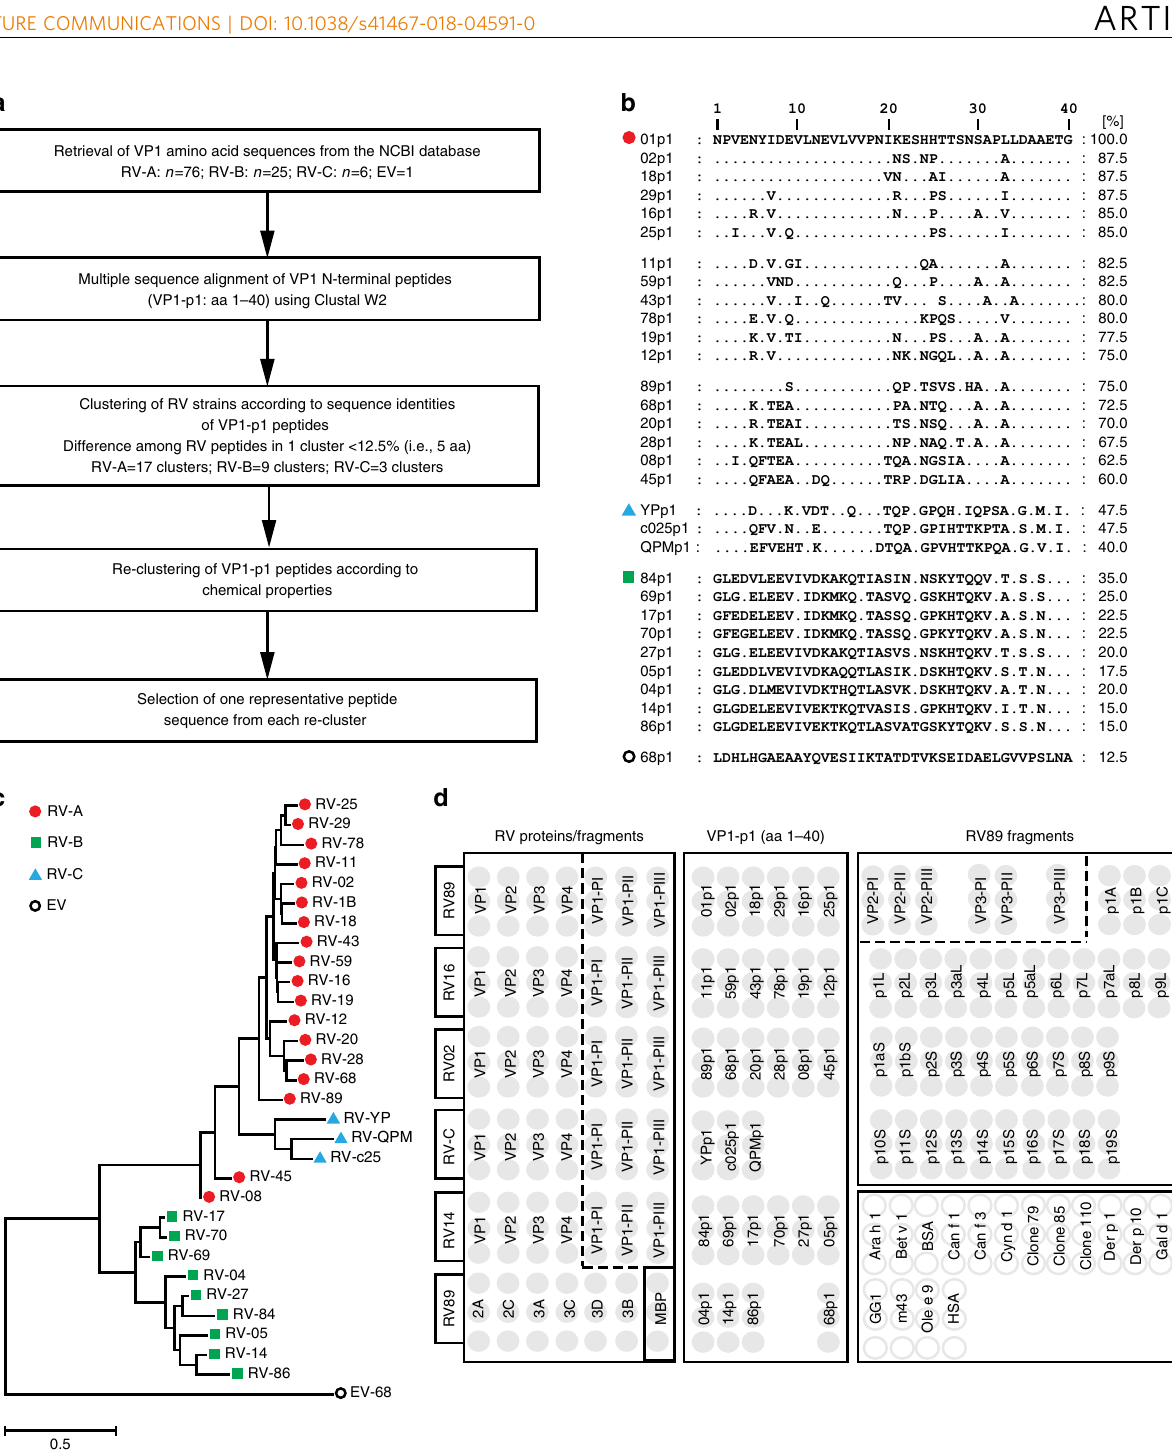
Fig. 1 Composition of the PreDicta chip. a Selection process of VP1 peptides representing different RV strains as summarized in Supplementary Table 2. b Multiple sequence alignment of selected VP1 peptides. Left margin: Strain numbers (red circle: RV-A; blue triangle: RV-C, green square: RV-B, black circle: Enterovirus 68). Dots in the alignment represent identical amino acids. Sequence identities (%) with peptide 1 from RV 1 (01p1; top line) are shown for each peptide on the right margin. c Phylogenetic tree of the VP1 peptide sequences in b . d RV microarray layout depicting the positions of recombinant RV proteins/protein fragments, synthetic peptides (VP1-p1, 89VP1-derived peptides), MBP (maltose binding protein), and other control proteins which were spotted in triplicates. Proteins and peptides are designated as described in Supplementary Tables 3 –